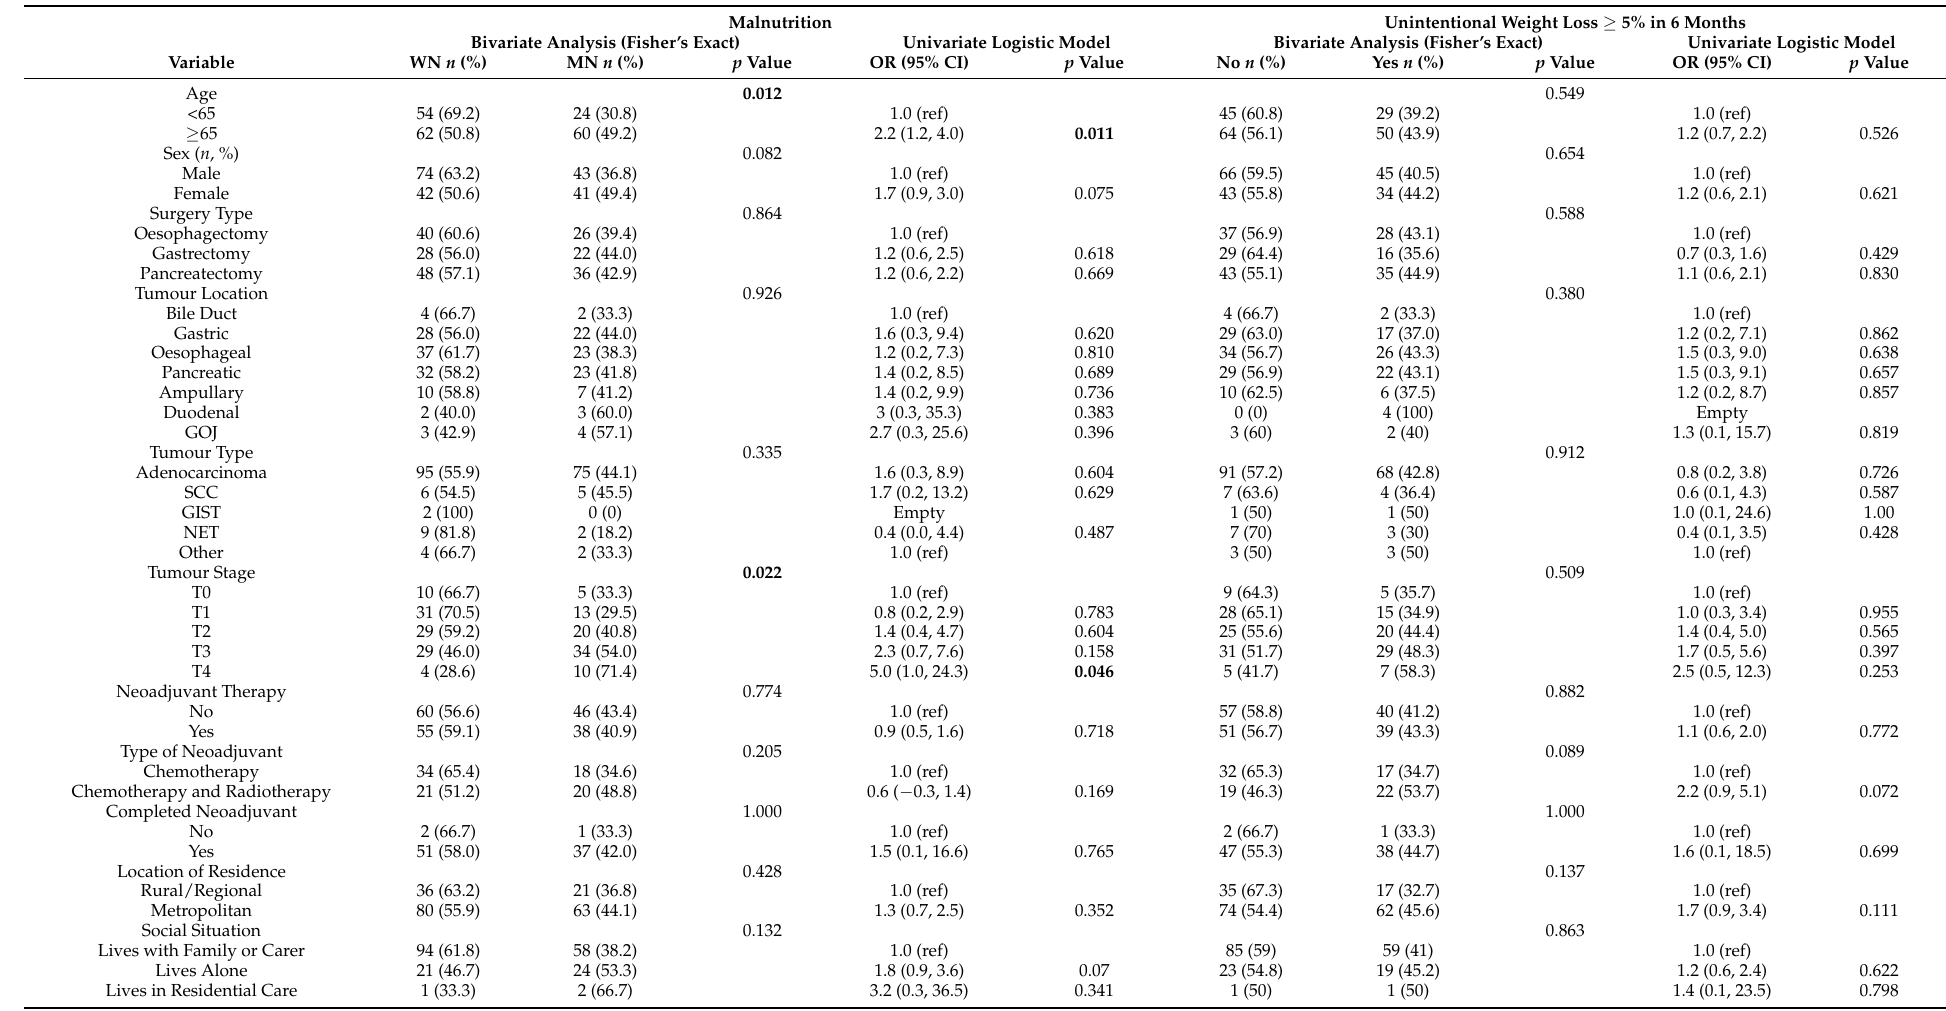
Table 3. Demographic and clinical factors associated with malnutrition and clinically significant weight loss ( ≥ 5% in 6 months) prior to surgery ( n =